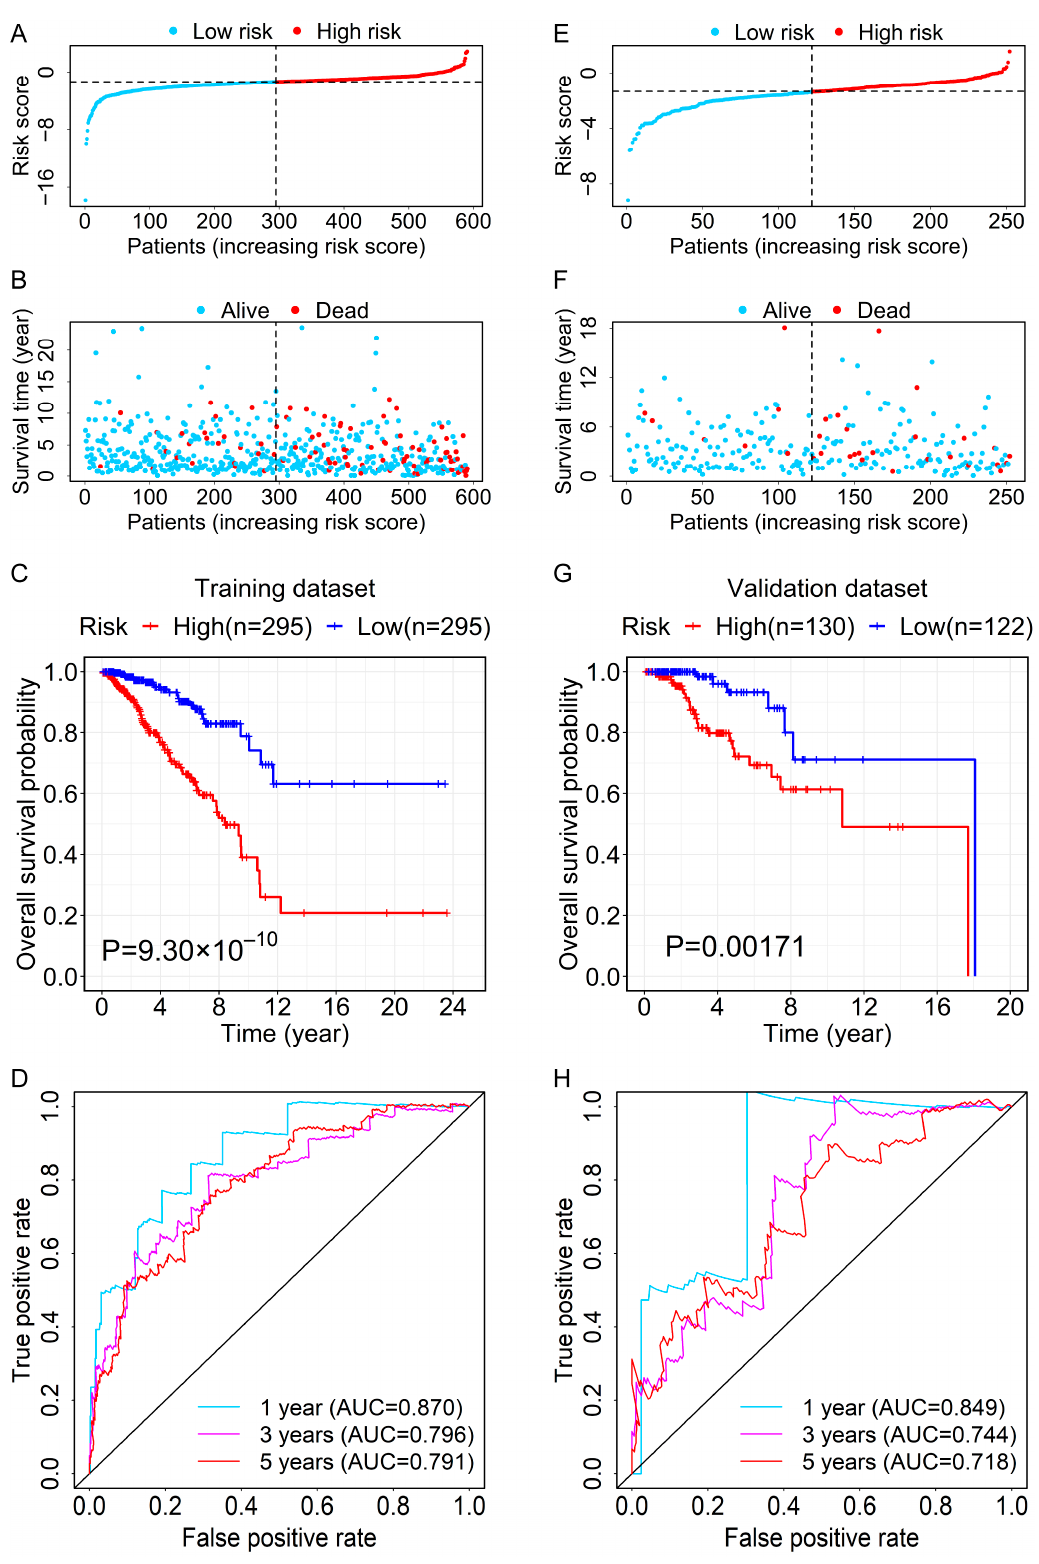
Figure 2. Evaluation and verification for the prognostic value of the RBP-related lncRNA signature. ( A ) Risk scores for BC patients of the high- and low-risk groups in the training dataset. ( B ) The scatterplot of overall survival time and status of BC patients in the high- and low-risk groups from the training dataset. ( C ) The OS curve for BC patients in the high- and low-risk groups of the training dataset. ( D ) The time-dependent ROC curves at 1-, 3-, and 5-year OS of the 12-lncRNA prognostic signature in the training dataset. ( E ) Risk scores for BC patients of the high- and low-risk